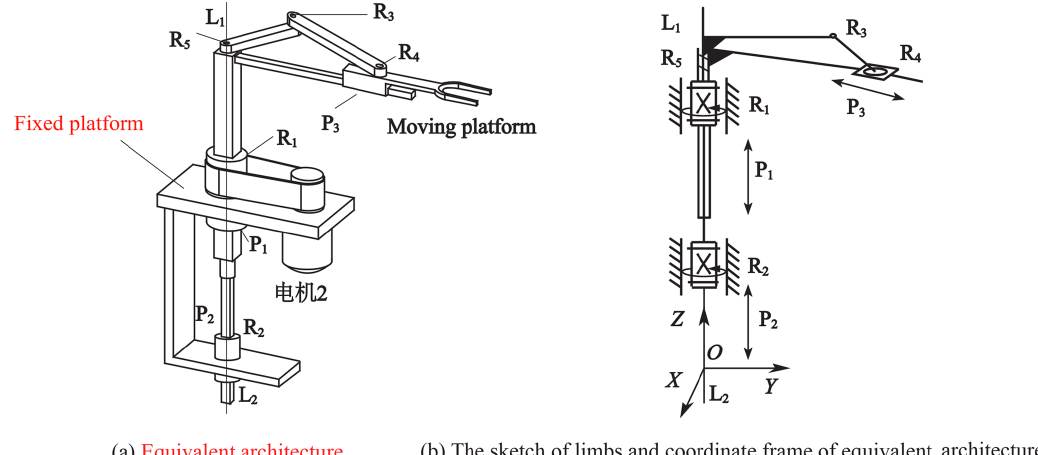
Figure 5. The 3-DoF PM with limbs of embedding structures after reselecting actuated pairs.